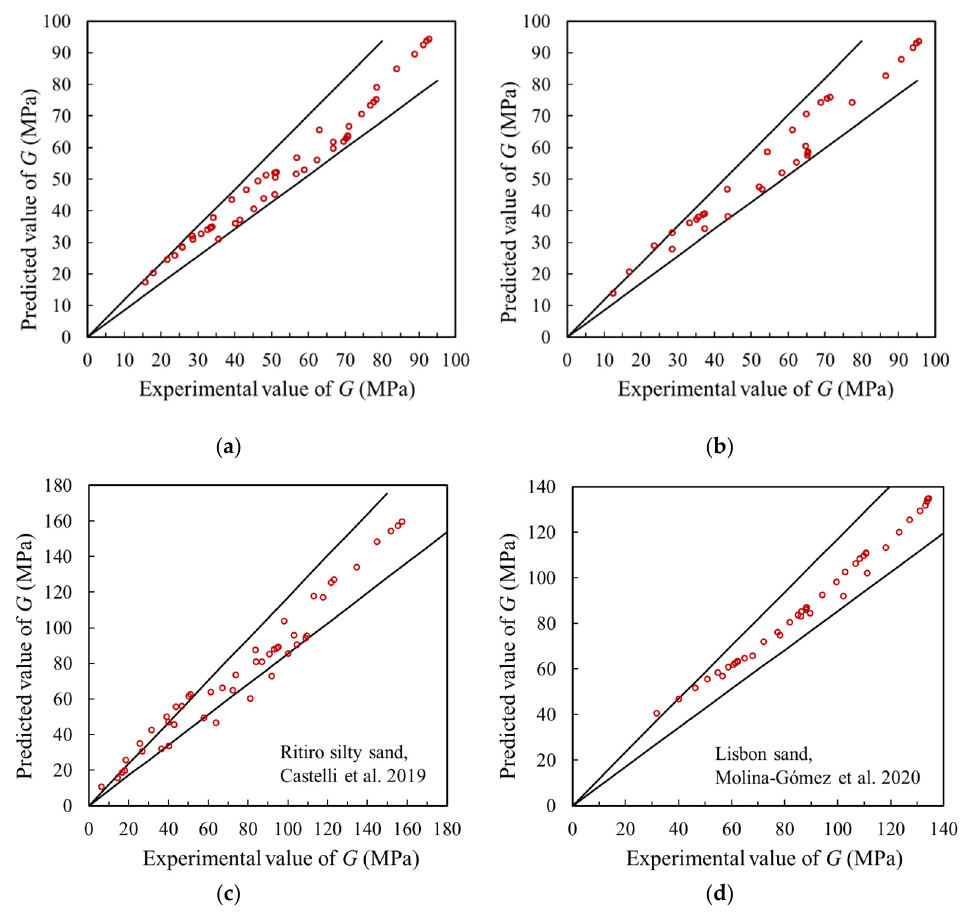
Figure 5. Predicted results of G using Equation (3) for ( a ) silty sand; ( b ) medium sand; ( c ) experimental data of G from the resonant column tests of Castelli et al. (2019); ( d ) experimental data of G from the resonant column tests of Molina-Gómez et al. (2020).